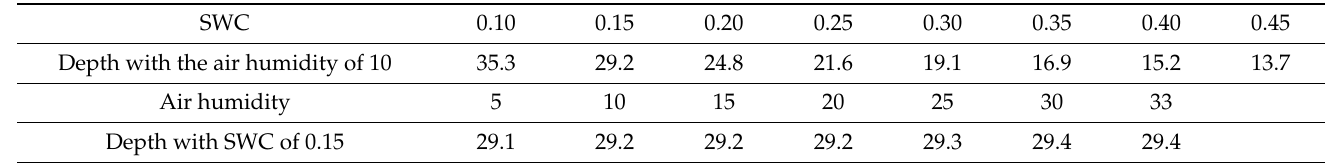
Table A2. Detection depth obtained by simulations under different SWCs (cm 3 · cm − 3 ) and air humidities (g · cm − 2 ). The pattern of variations in the detection depth values indicates the impact of SWC and air humidity on detection